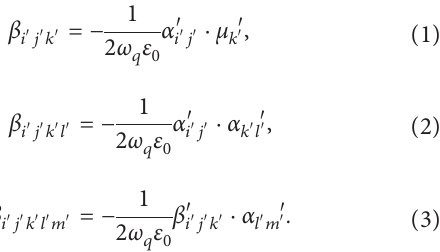
Figure 1: Molecular coordinate system of (C) lecular